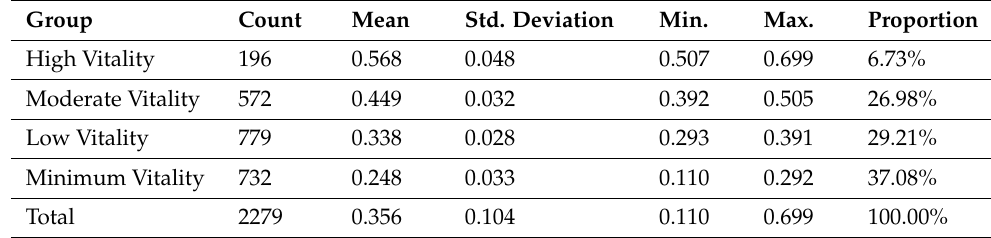
Figure 10. JANE index classification analysis. Table 2. JANE index group statistics